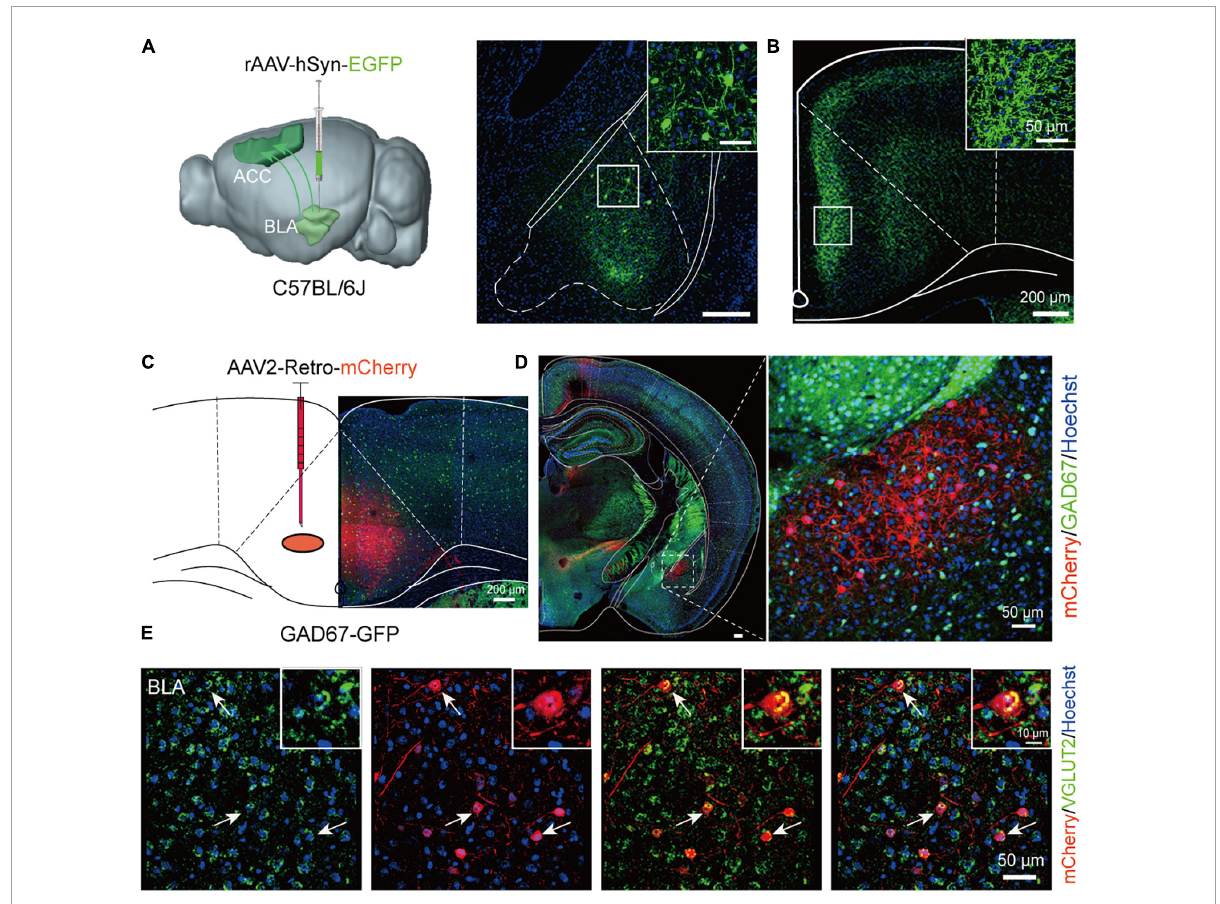
FIGURE3 Basolateral amygdala (BLA) neurons send glutamatergic projections to the anterior cingulate cortex (ACC). (A) Schematic of a sagittal section of the mouse brain showing the injection of the rAAV-hSyn-EGFP virus into the BLA of C57BL/6J mice. (B) The ACC region received a large number of projection fiber terminals from the BLA. Scale bar, 200 µ m. (C) Schematic of a coronal section of the mouse brain showing the injection of the AAV2-Retro-mCherry virus into the ACC of GAD67-GFP mice. Scale bar, 200 µ m. (D) The cell bodies of BLA neurons showed red fluorescence after retrograde tracing from the ACC. Scale bar, 50 µ m. (E) The in situ hybridization results showed that the Vglut2 probe was colabeled with mCherry-positive neurons in the BLA (The white arrow showed the typically colabeled mCherry positive neurons with Vglut2 ). Scale bar, 50 µ